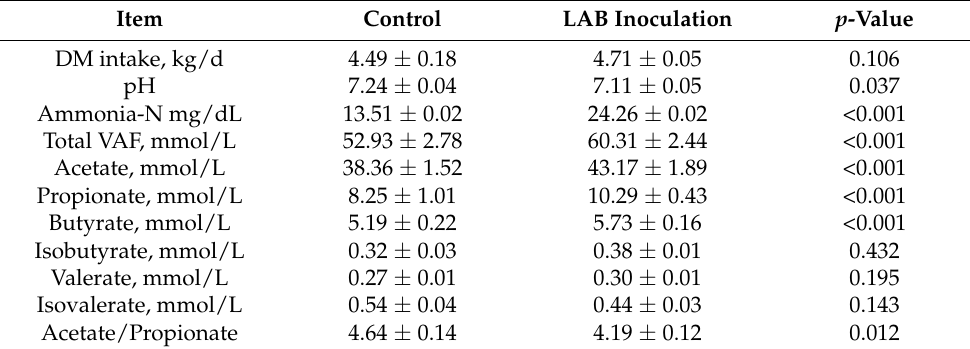
Table 2. DM intake and yak rumen fermentation